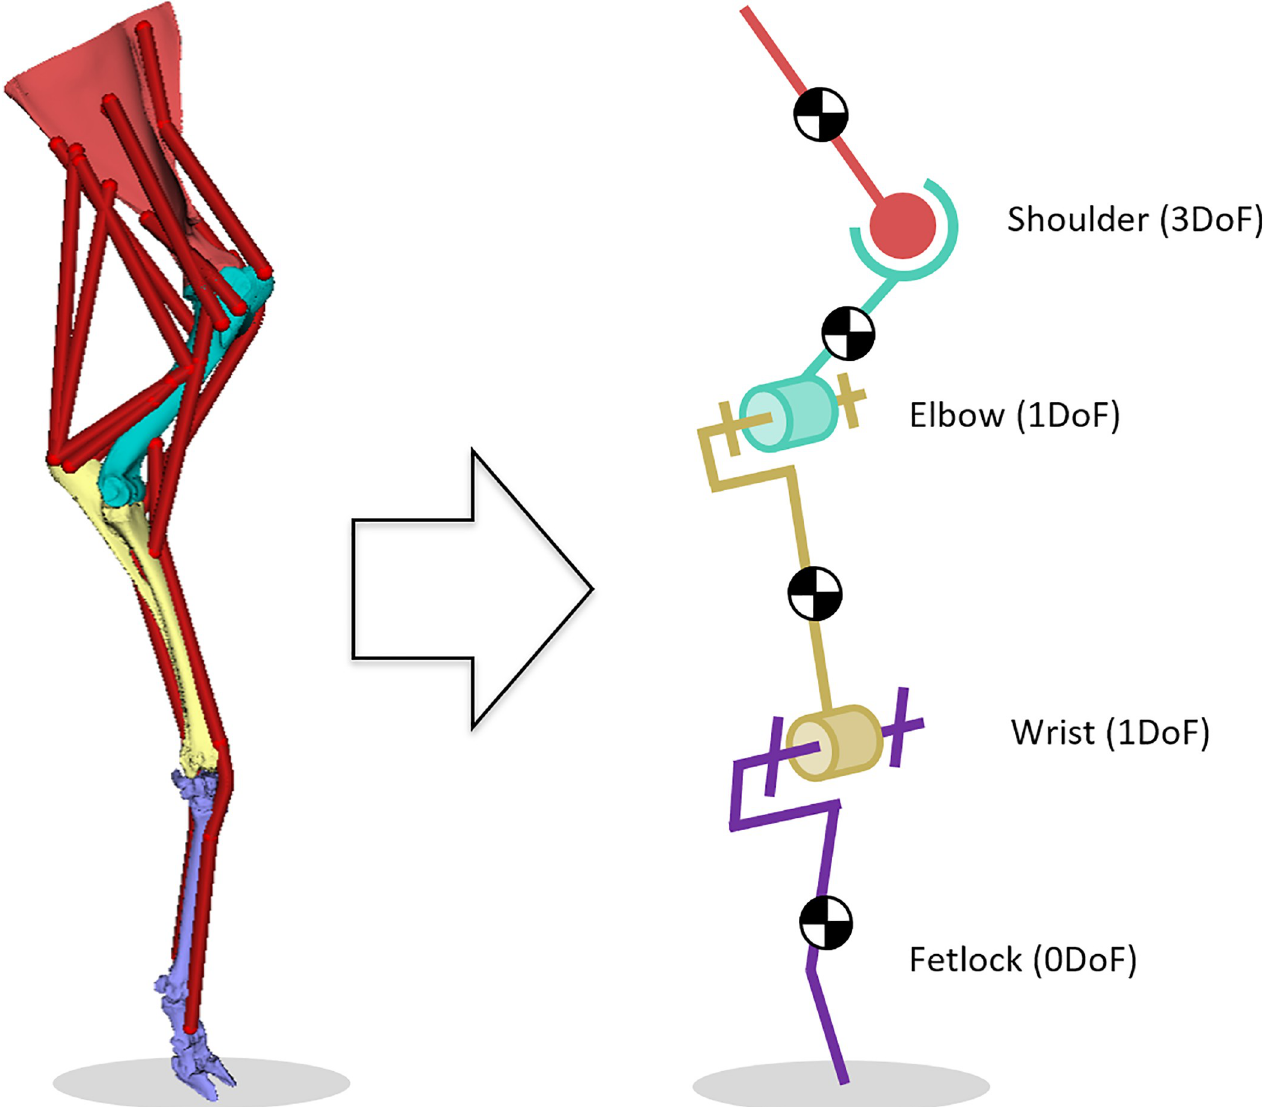
Fig 6. OpenSim model of the right thoracic limb of a sheep with initial elbow modelling as revolute joint.